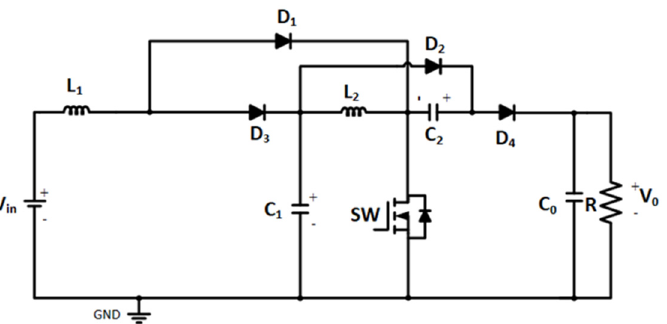
Figure 3. Circuit configuration of modified QBC with voltage lift capacitor integrated with series with Inductor L 2 .